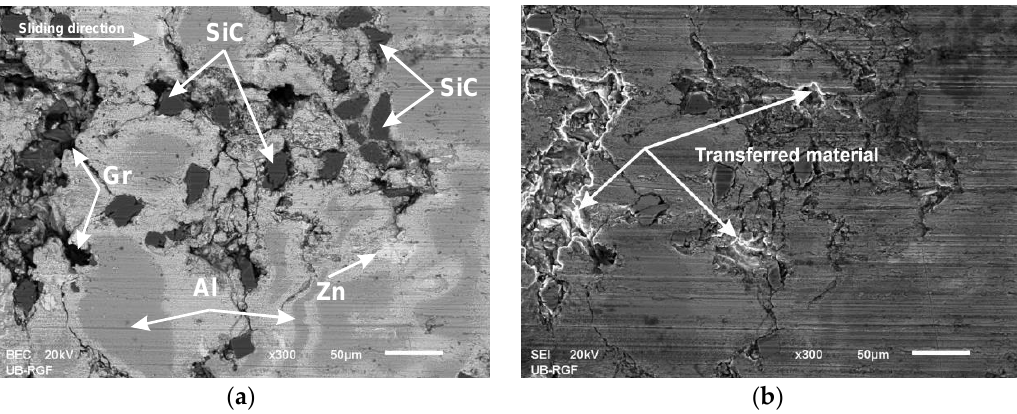
Figure 9. Worn surface of ZA27/5%SiC/5%Gr for 120 N of normal load and 0.25 m/s of sliding speed: ( a ) backscattered electrons image (BEC) image; ( b ) secondary electrons image (SEI) image.